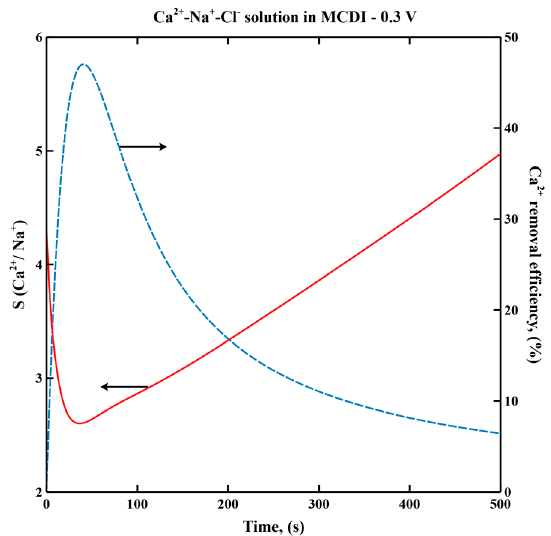
Figure 2. Transient Ca 2+ selectivity and Ca 2+ removal efficiency in Ca 2+ -Na + -Cl − solution during desalination in MCDI. Feed concentration of each cation is 20 mol/m 3 . Applied voltage is 0.3 V. Ratio of hard sphere diameter to hydraulic diameter, C is taken as 1.25.